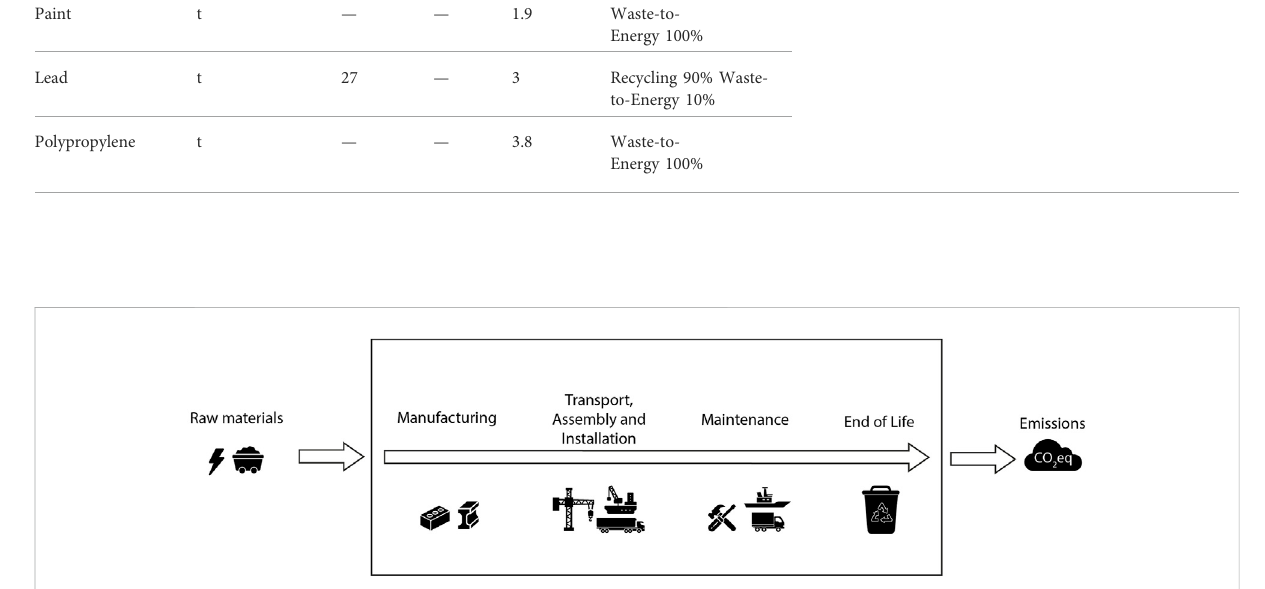
FIGURE 4 Flow chart representing the main life cycle phases involved in the assessment ( “ cradle-to-grave ” ).